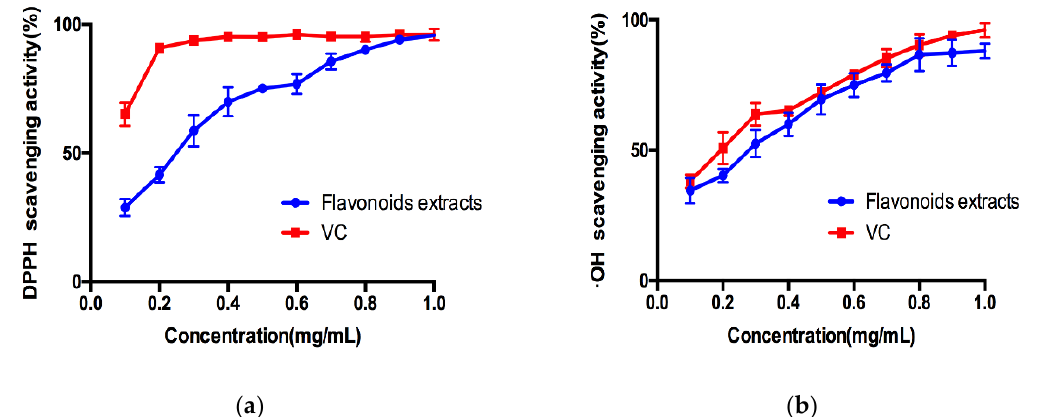
Figure 4. Antioxidant activity of Sophora flavescens extracts. ( a ) 1,1-diphenyl-2-picrylhydrazyl (DPPH) radical scavenging activity. ( b ) Hydroxyl radical scavenging activity. Data represent means ± SD of three independent experiments.